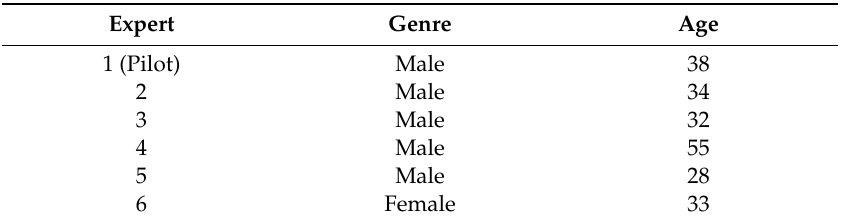
Table 4. Expert evaluators